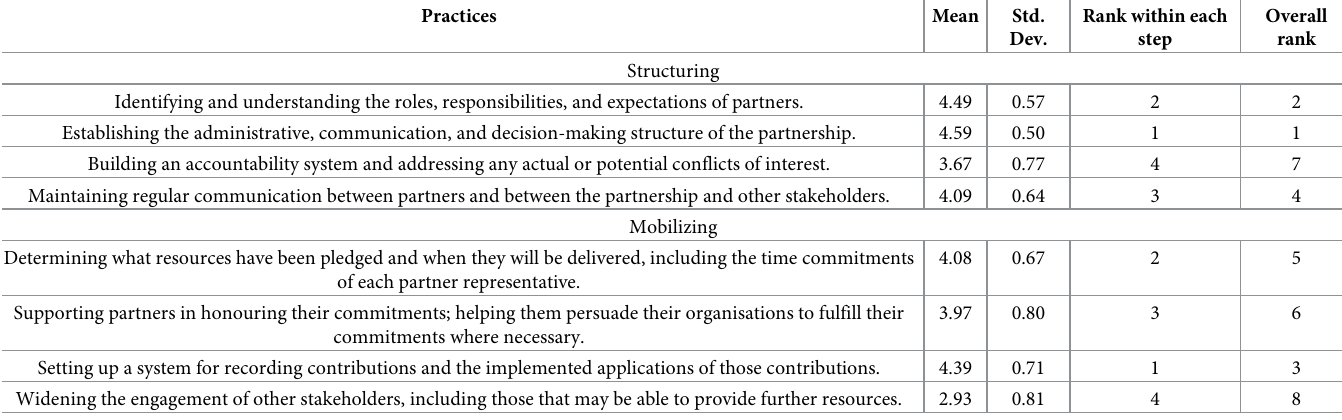
Table 3. Descriptive results of managing and maintaining practices followed by